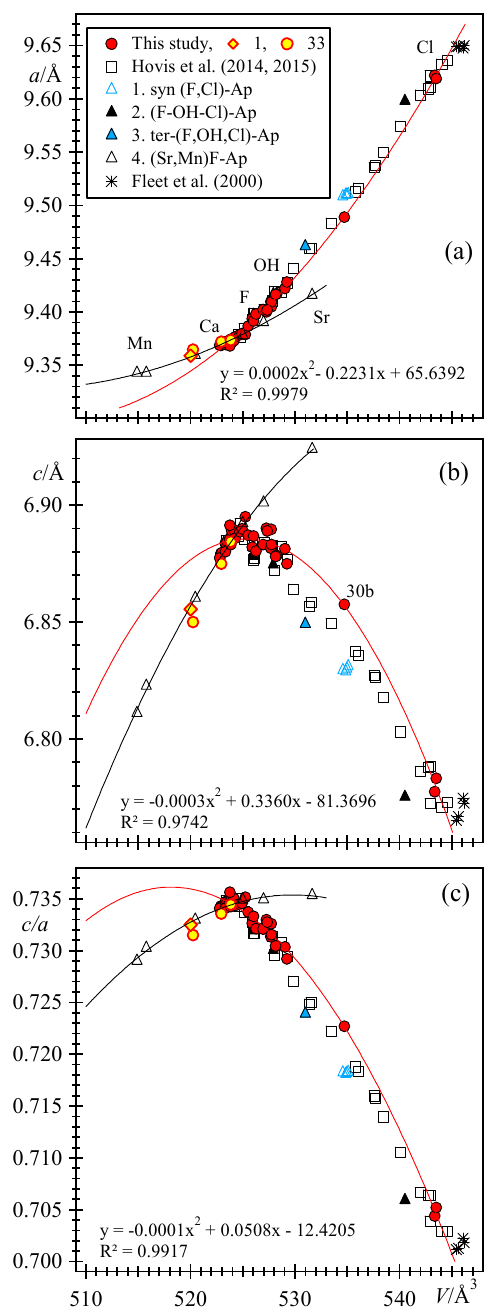
Figure 8. Variations of the unit-cell parameters ( a ) a , ( b ) c , and ( c ) c / a with volume, V , across natural Ap solid solutions. The a axis increases non-linearly with increasing V , whereas both the c axis and the c / a ratio increase and then decrease in a convex-up manner. The red trend lines (equations inserted) are based on data only from this study (red circles) for Ca-rich Ap. Sample-30b, which is an (OH,Cl)-rich Ap, has a V that plots about midway between OH-Ap and Cl-Ap. Data indicated by triangles are from one group of researchers (see Table S5). The literature data for the larger a unit-cell parameter are close to the red trend line in ( a ), but these are further apart in ( b , c ), as smaller values are more difficult to measure. The data for group-4 samples (black open triangles) are for (Sr,Mn)F-Ap and these give rise to the black trend lines. Our samples-1 and -33 (yellow symbols) fall close to the black trend lines, so these are not included in the red-trend line computation.